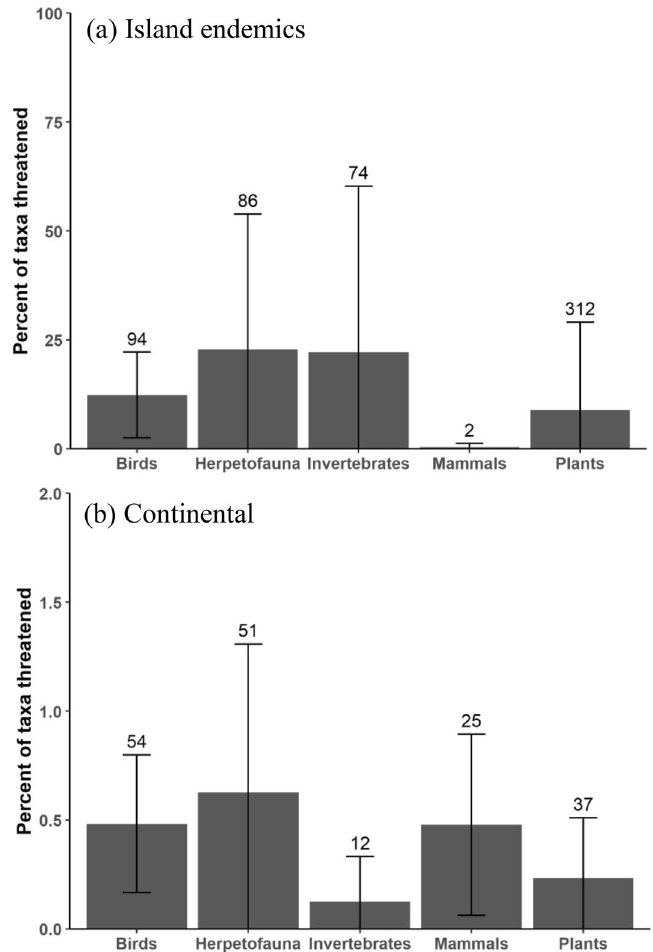
Figure 4. Mean percentages of all extant or extinct taxa identified as being threatened by wild pigs on the IUCN Red List across all ( a ) island endemic taxa (n = 8 regions) and ( b ) continental taxa (n = 9 regions). Numbers above errors bars are the total number of ( a ) island endemic taxa and ( b ) continental taxa threatened by wild pigs for each taxonomic group. Bars are ± 1 SD. Note: scales for ( a ) endemic taxa are 0–100% and ( b ) continental taxa are 0–2%. See “Methods” for